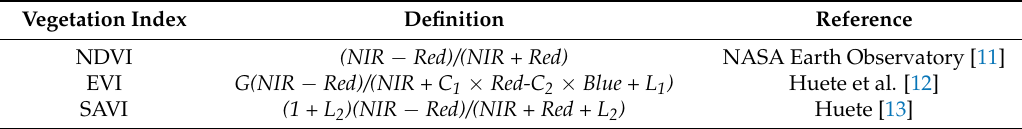
Table 1. Normalized difference (NDVI), enhanced (EVI), and soil-adjusted (SAVI) vegetation indices’